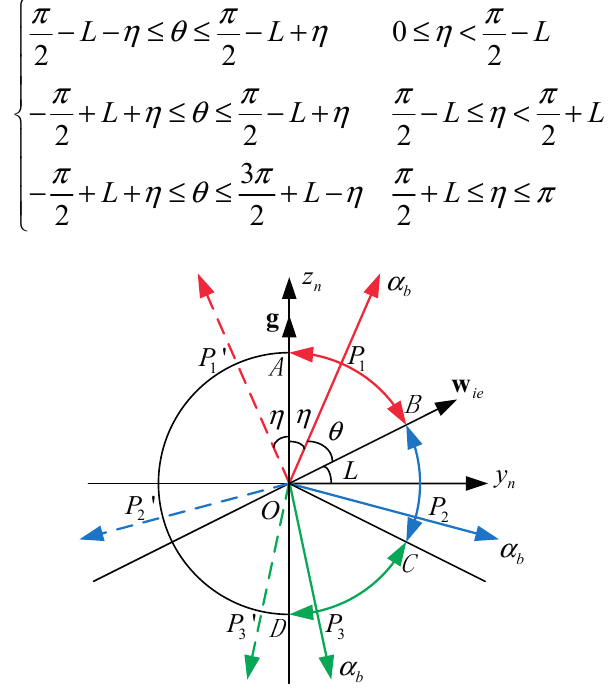
Figure 4. The critical point for the intersection of the two conical surfaces, where ' the reflection of